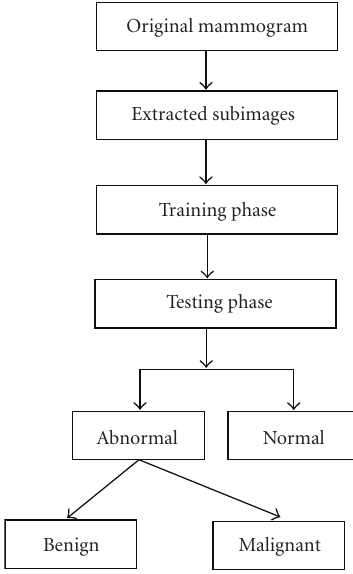
Figure 3: Block diagram of the proposed CADD